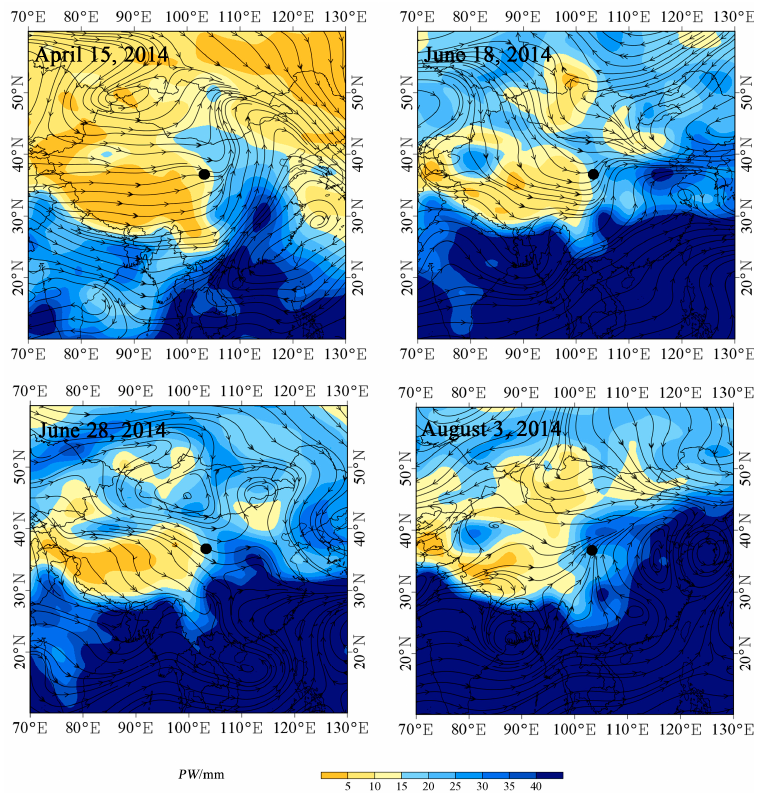
Figure 10. Water vapor stream and precipitable water amount ( PW ) surrounding the study region during four typical rainfall events.